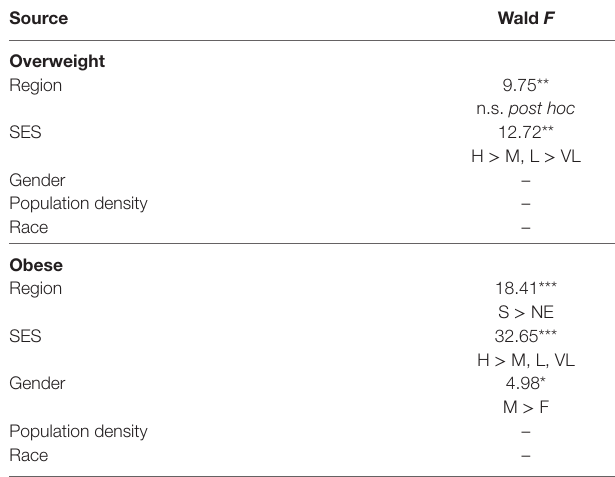
Boldface indicates a significant difference between groups after post hoc correction for multiple comparisons. OR, odds ratio; CI, confidence interval. a Reference group for comparisons between races. TaBle 7 | Multivariable analyses for overweight and obesity across sociodemographic